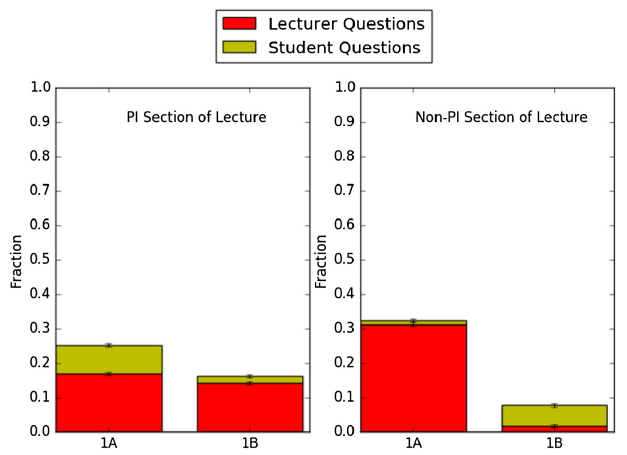
FIG. 4. Fraction of PI and non-PI section of lecture spent on lecturer questions vs student questions for 1A and